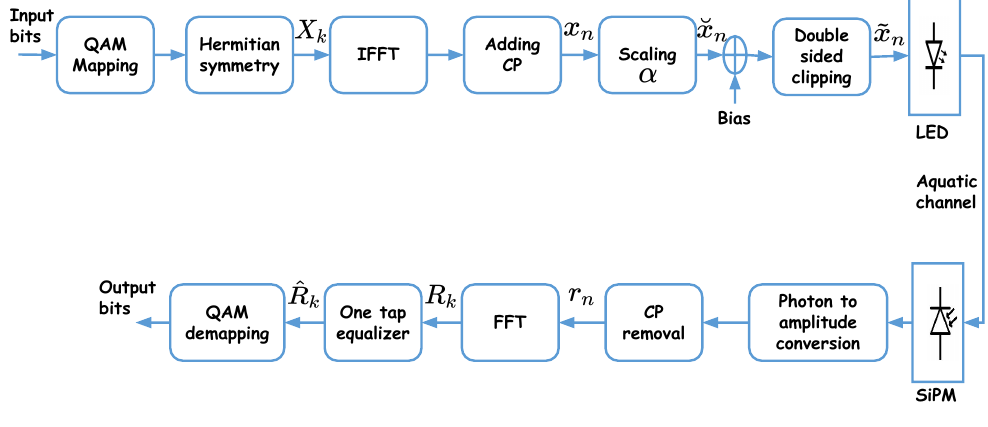
Figure 1. Block diagram of the DCO-OFDM signaling